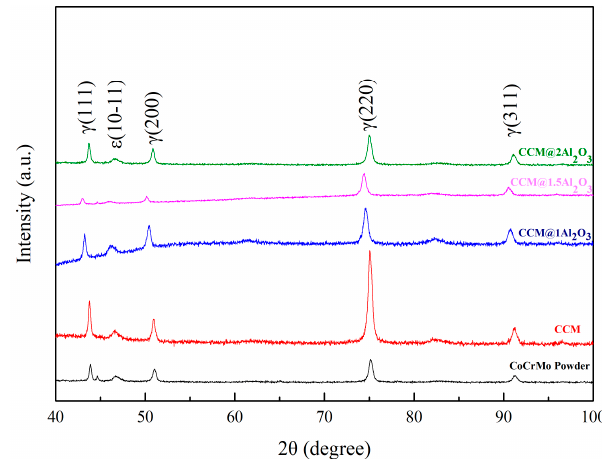
Figure 8 . Phase analysis results measured by XRD. Figure 8. Phase analysis results measured by